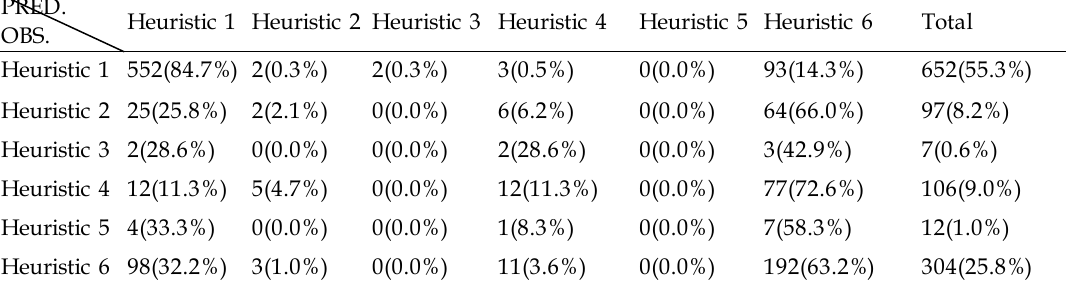
Table 9. Confusion Matrix of Bayesian networks based on a 5-fold cross validation method PRED.